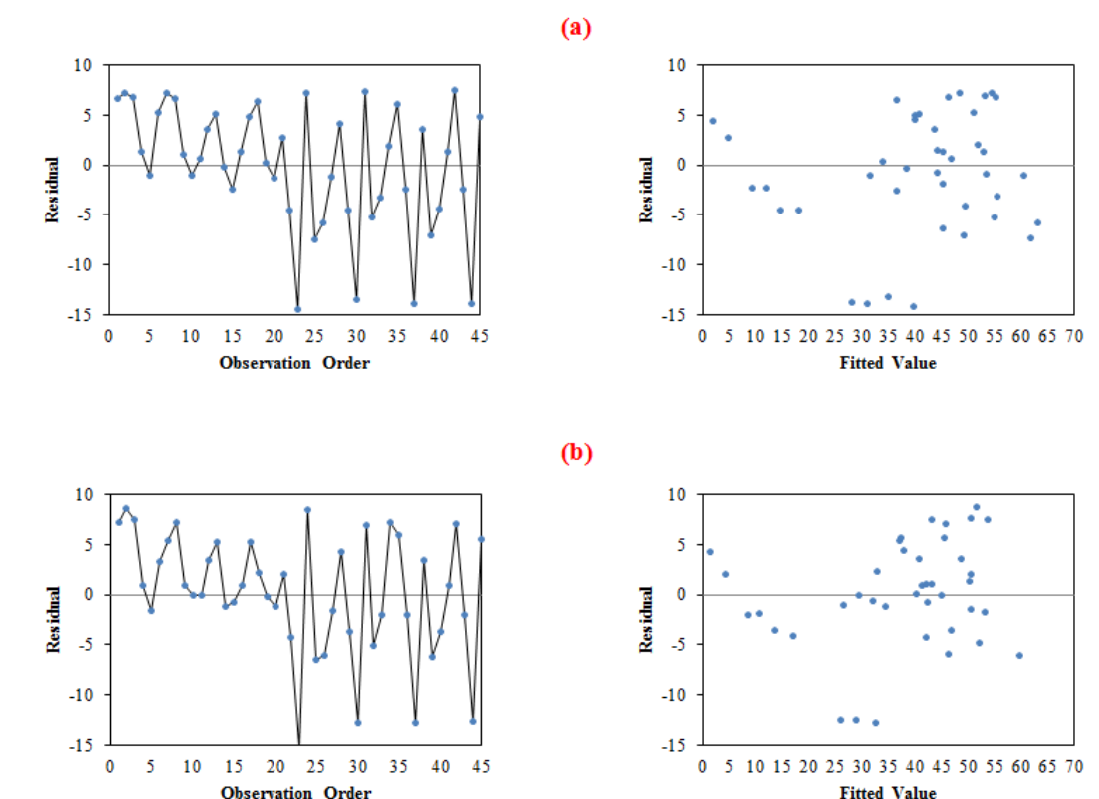
Figure 5. Residuals versus the observation orders and fitted values plot for the permeability of ( a ) AB-210, and ( b ) RB dyes.